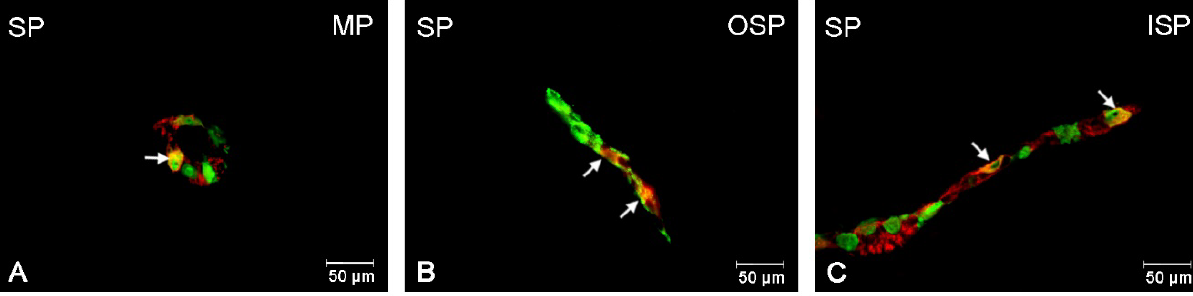
Figure 10. Fluorescence microscopy images showing protein gene product 9.5 (PGP 9.5) visible as green fluorescence that colocalizes with substance P (SP) visible as red fluorescence in the enteric